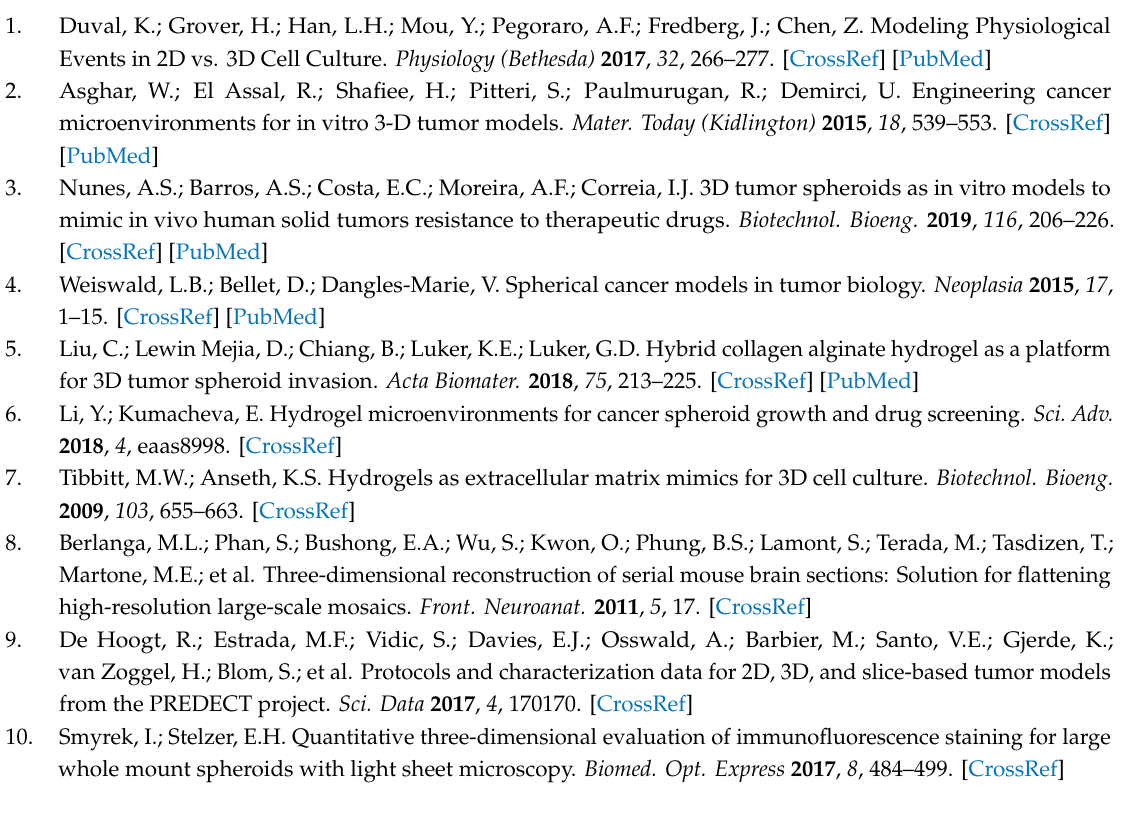
Figure S1: Schematic illustration of the minipillar array chip and jig for tissue optical clearing (TOC). Figure S2: Comparison of fluorescence confocal images acquired from cryosections and optical sections. Figure S3: Fluorescence images of PANC-1 tumor spheroids (TSs) and microtumors after tissue optical clearing (TOC). Figure S4: Dose-response curves of Gemcitabine (GEM) and Paclitaxel (PTX) in Capan-1